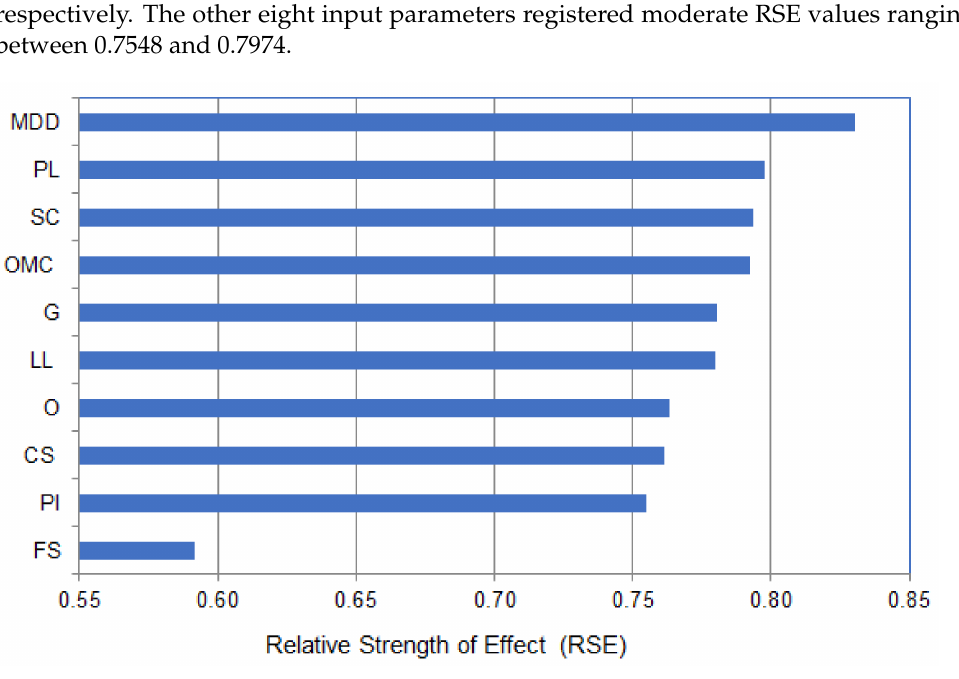
Figure 3. Sensitivity analysis of the input parameters predicting the CBR of